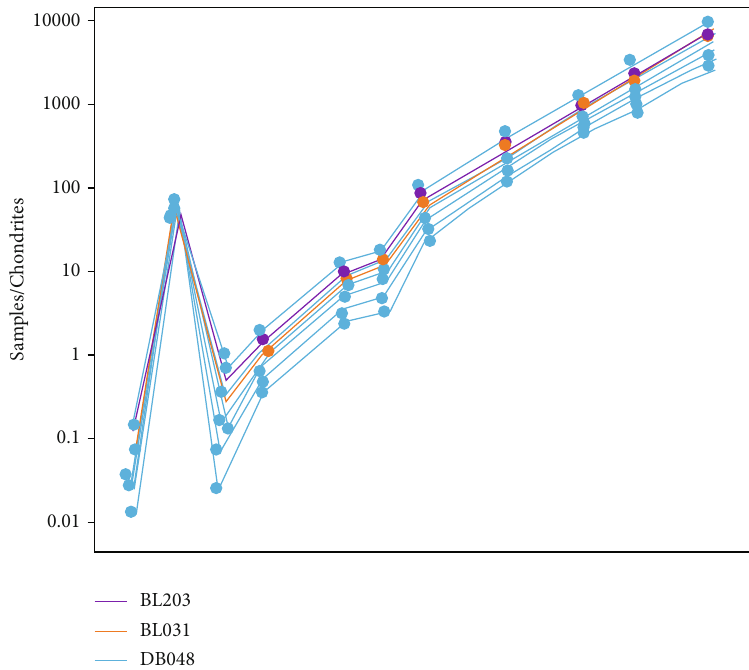
Figure 3: Normalized partition pattern of physicochemical eclogite zircon chondrites.